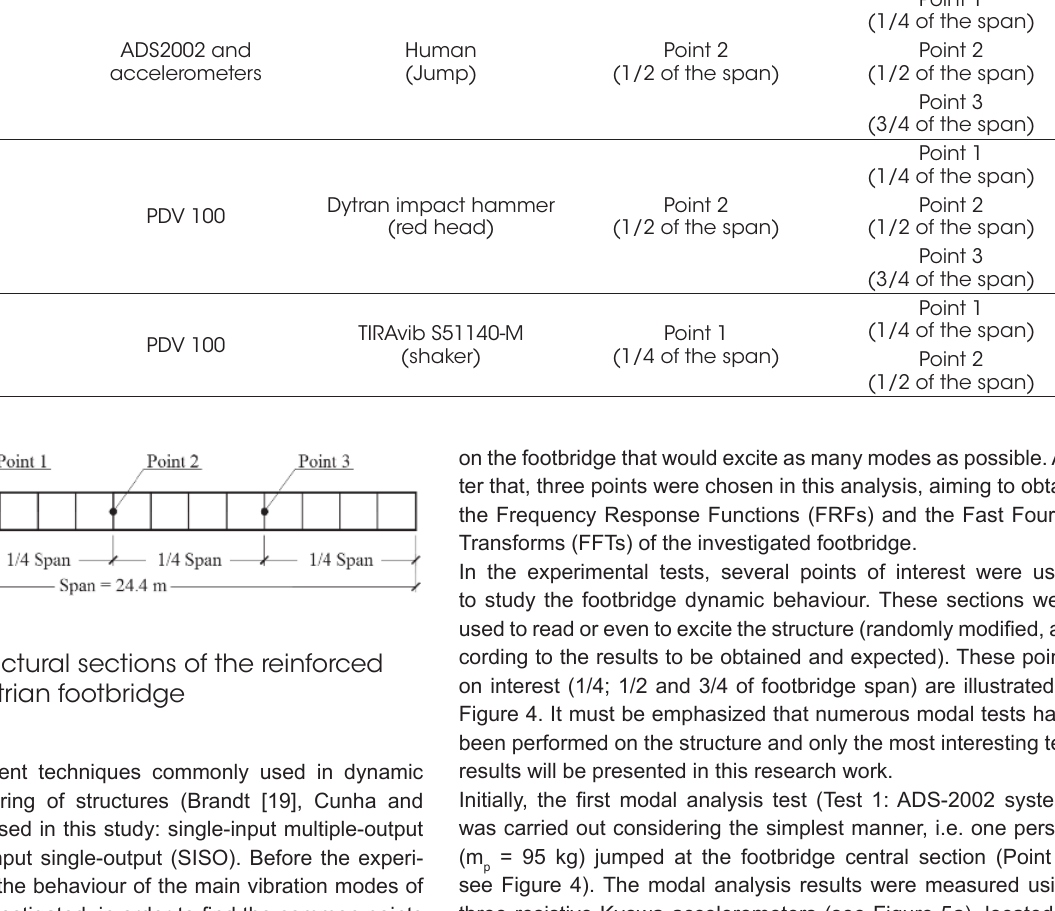
Experimental tests